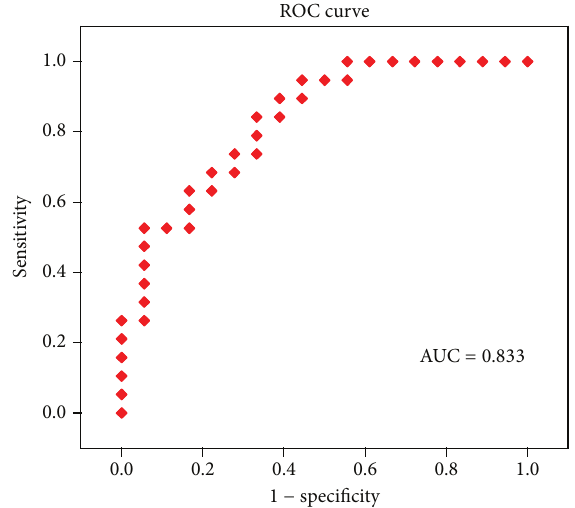
Figure 6: ROC curve for discriminating NPC from nasopharyngeal noncancerous ex vivo tissue for the training dataset by employing PCA-LDA diagnosis algorithms combined with LOOCV method. The AUC is 0.833.